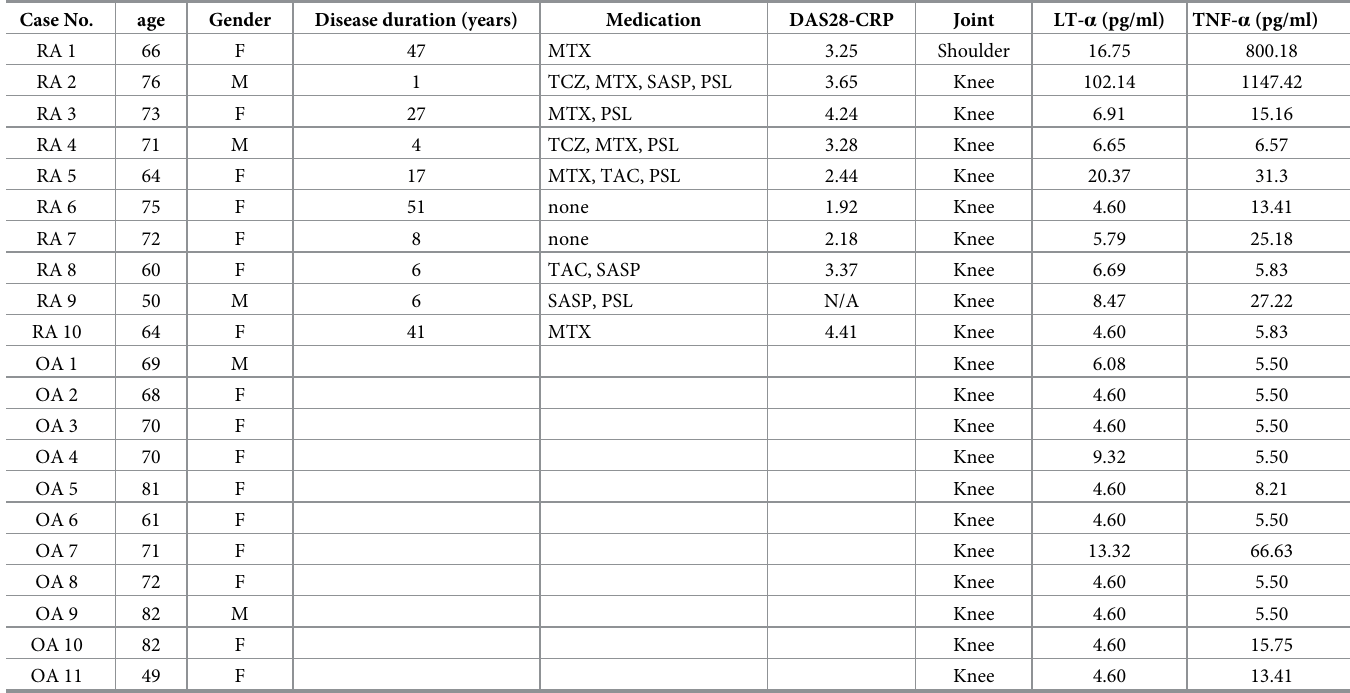
Table 1. Individual patient data and concentrations of LT– α and TNF– α in synovial fluid samples. Case